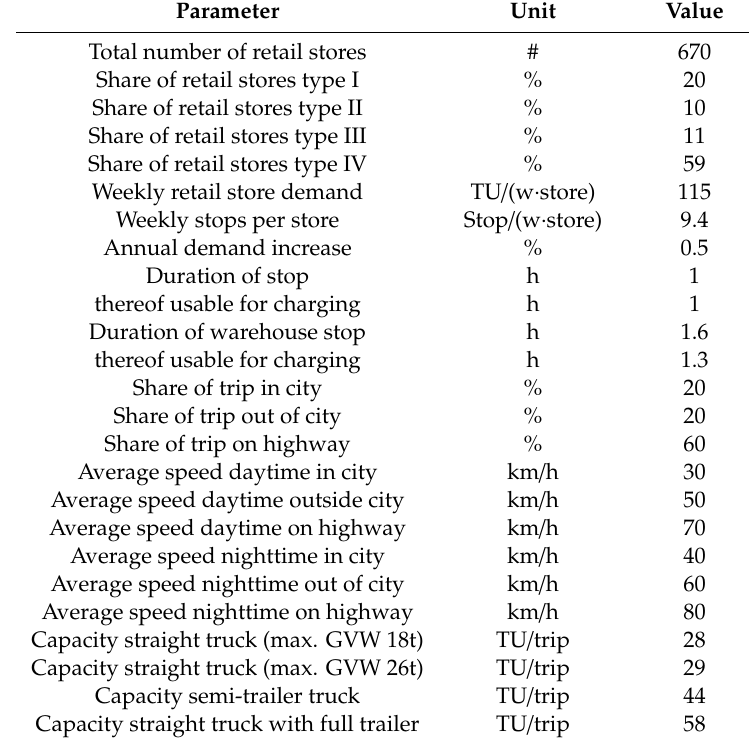
Table 2. Logistics